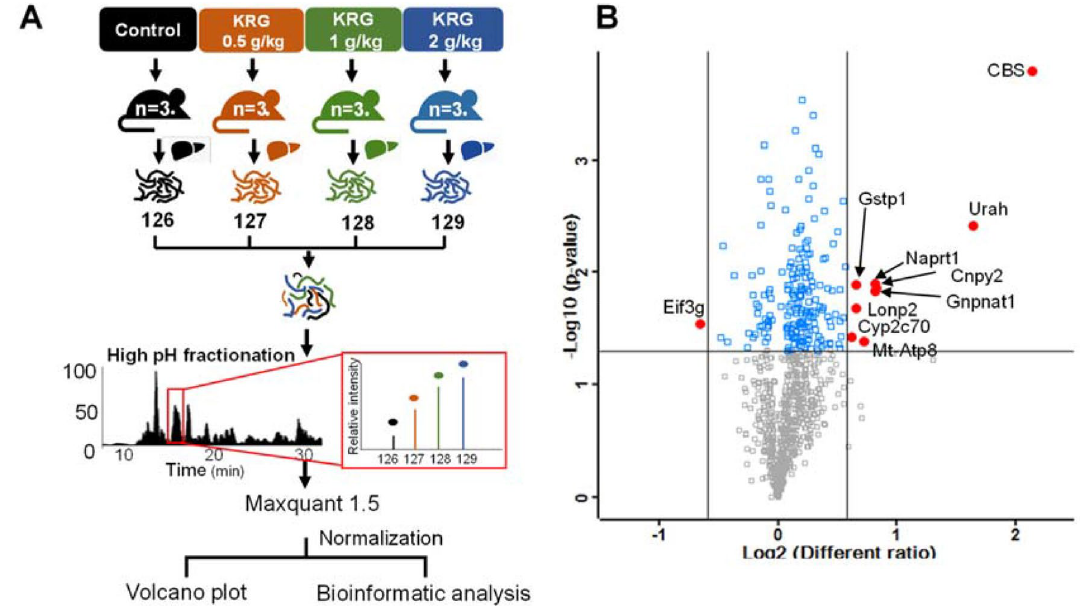
Figure 2. Overall scheme for the global proteomic profiling of mouse liver ( A ). Volcano plot and distribution of quantified proteins based on the reporter ion ratio in the three KRG groups ( B